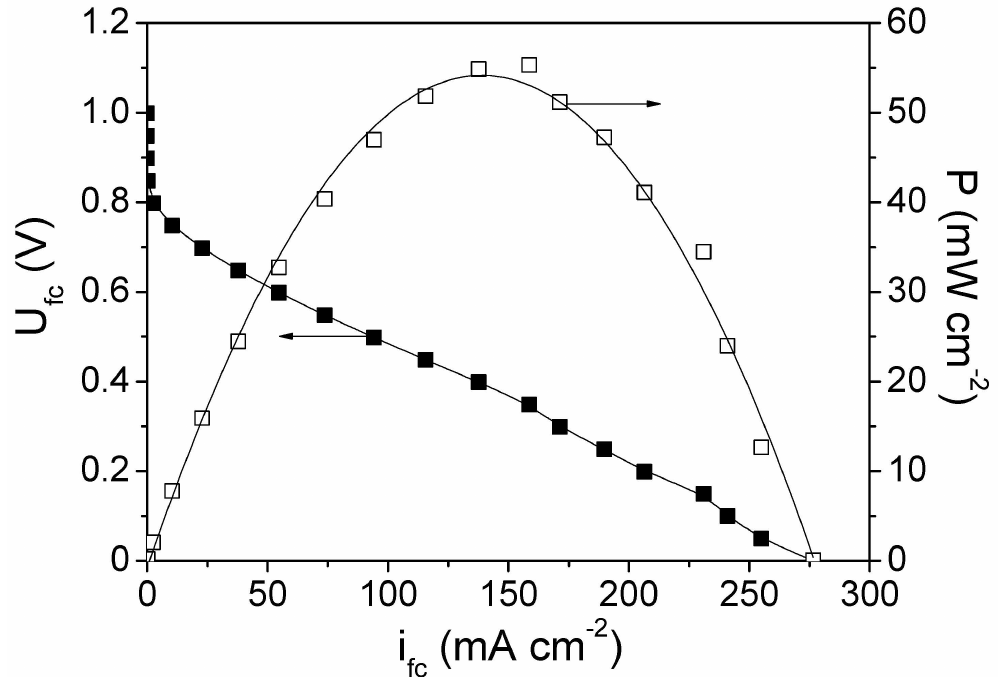
Figure 2. Cell potential ( U fc ) vs. current density ( i fc ) and power density ( P ) vs. current density ( i fc ) curves obtained for the PEMFC with the 29Pt cathode electrode; Flow rates: F anode (100% H 2 ) = F cathode (synthetic air) = 100 cm 3 min − 1 ; geometric electrode surface area, A elec = 5.29 cm 2